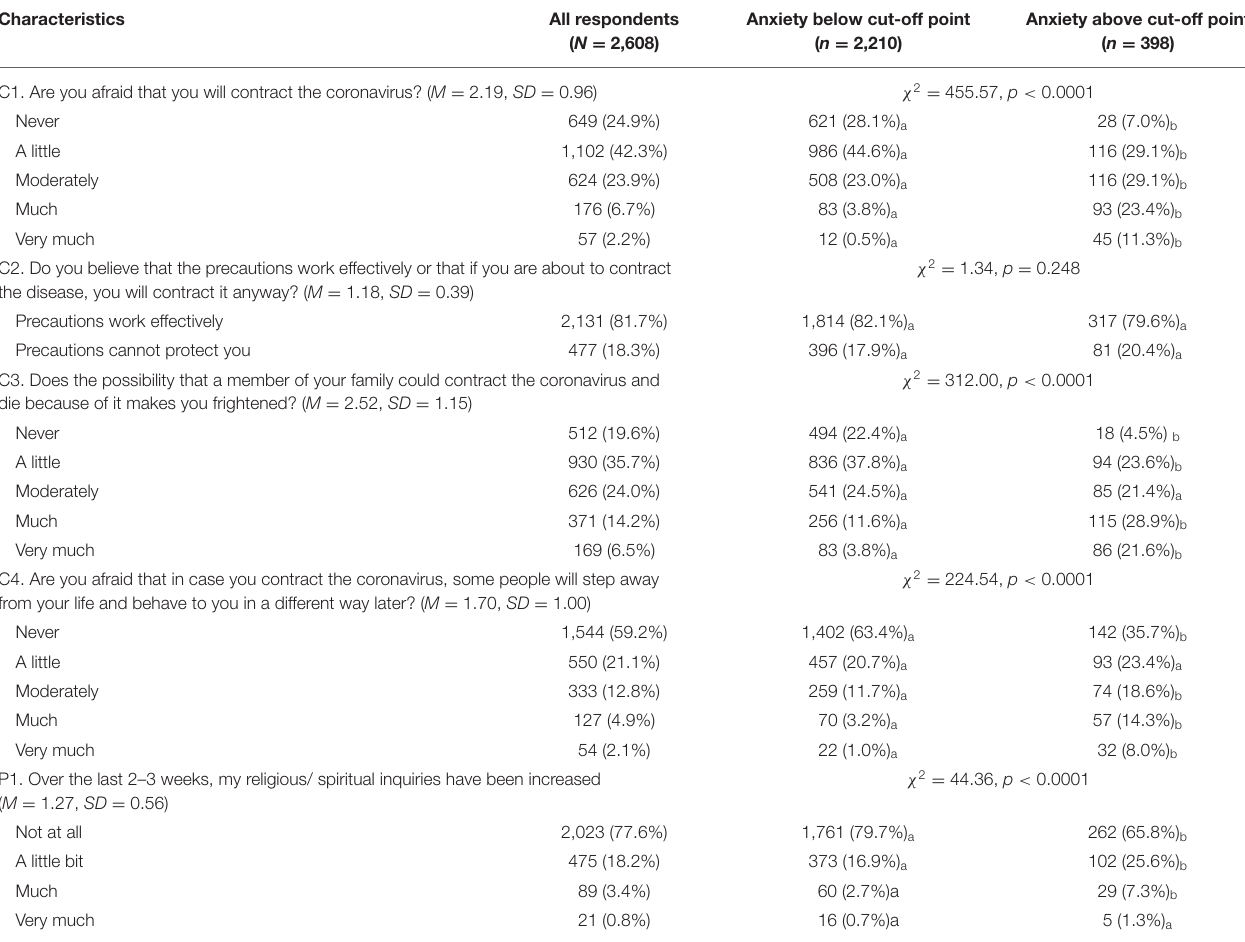
TABLE 4 | The association of anxiety and fears, thoughts about COVID-19, and religious/spiritual inquiries in the general population of Latvia during the COVID-19 state of emergency ( n = 2,608).